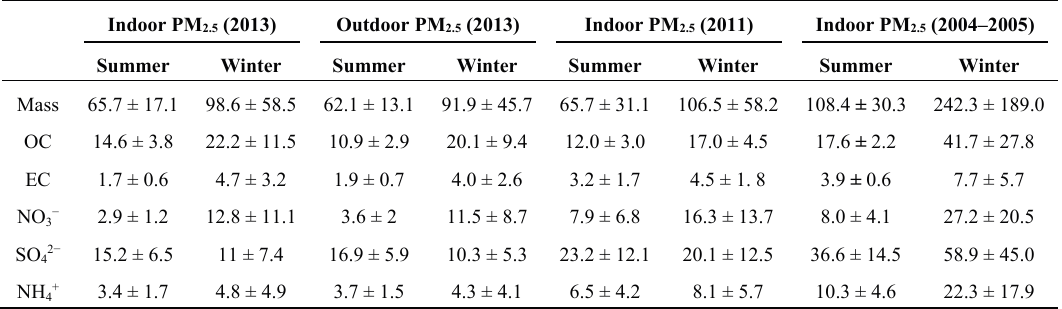
Table 2. Statistical summary of indoor and outdoor PM 2.5 chemical composition for 24-hour integrated samples acquired over the summer and winter periods in 2004–2005 [17], 2011 [25] and 2013 (in this study) campaigns at the Emperor Qin’s Terra-Cotta Museum in Xi’an, China. OC, organic